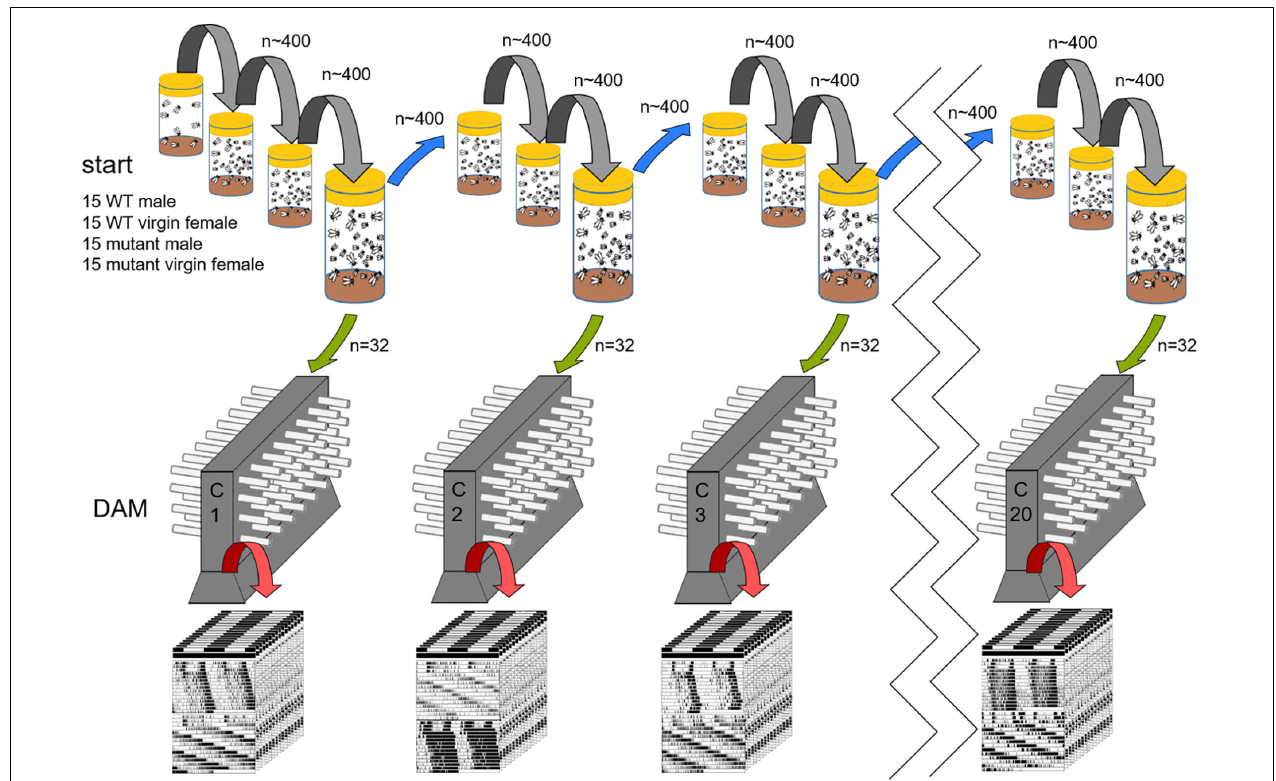
FIGURE 1 | Experimental procedure. At the start of the experiment, 15 male and virgin female flies each of wildtype (WT) and one period mutant were placed in a large food vial (60 flies in total). The mutant flies were either per s , per l or per 0 . All wild type/mutant competitions were started with 10 vials (=populations) each. Here, the procedure is only shown for one population. Every 14 days (gray and blue transfer arrows), all hatched animals ( ∼ 400 flies) were transferred into fresh food vials. After every third transfer, a census was taken. For this, the vials were kept for another 2 to 3 days so that more flies could hatch. From these, 32 males were randomly chosen (green arrow) and their activity was recorded in a Drosophila Activity Monitor (DAM), [Census 1 (C1), Census 2 (C2), etc.]. After 4–7 days of entrainment under light dark cycles (LD12:12) the animals were recorded in constant darkness (DD) for another 2 to 3 weeks. Afterward the genotype of the flies was determined and the period of the rhythmic flies calculated (see section “Materials and